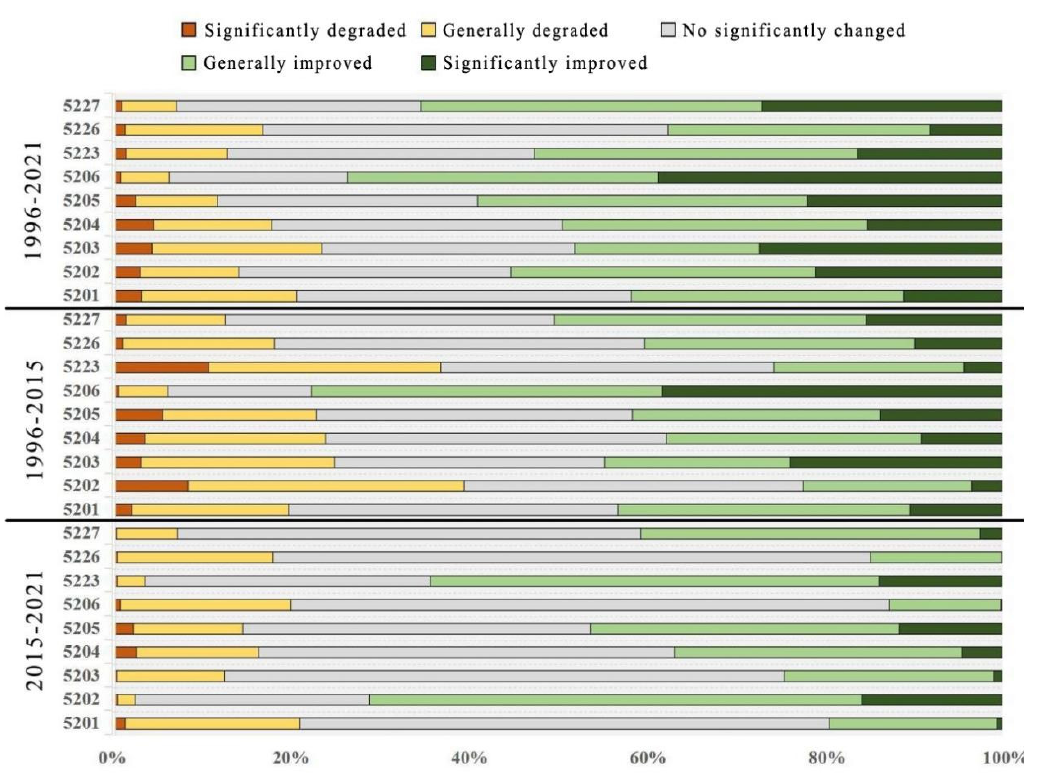
Figure 8. EEQ dynamics by classified RSEI in prefecture; grade changes are divided into five grades, namely, remarkedly degraded ( ≤− 2), generally degraded ( − 1), no striking change (0), generally ameliorated (1), and strikingly ameliorated ( ≥ 2). Administrative codes are represented as follows: 5201 is Guiyang, 5202 is Liupanshui, 5203 is Zunyi, 5204 is Anshun, 5205 is Bijie, 5206 is Tongren, 5223 is Qianxinan, 5226 is Qiandongnan, and 5227 is Qiannan.